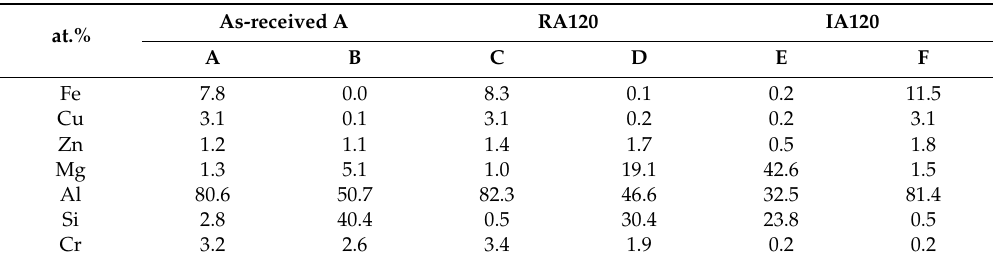
Table 5. EDS analysis results for specimens as-received B, RB120, and IB120, as shown in Figure 5d–f, respectively. at.%